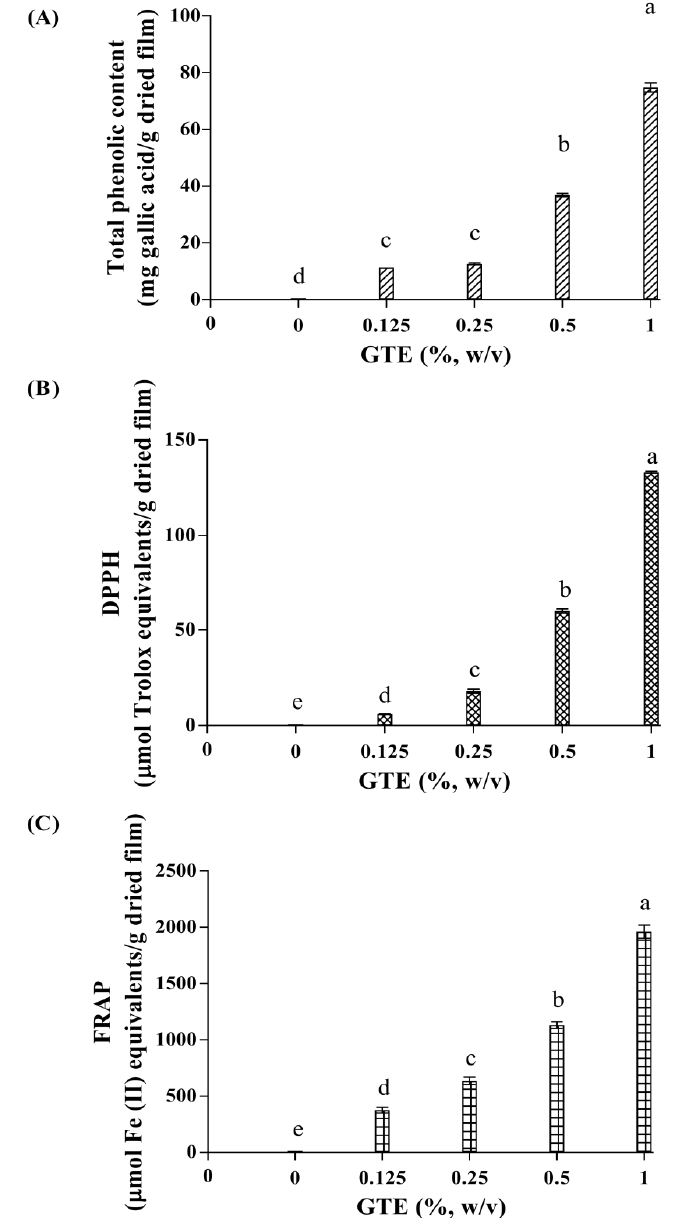
Figure 3. Total phenolic content ( A ), DPPH ( B ), and FRAP ( C ) of rice-starch-pectin films incorporated with green tea extract (GTE) at different concentrations. The numbers designate concentrations of green tea extract (%, w / v ). Values ( n = 3) are given as mean ± SD. Different letters indicate significantly different ( p < 0.05).